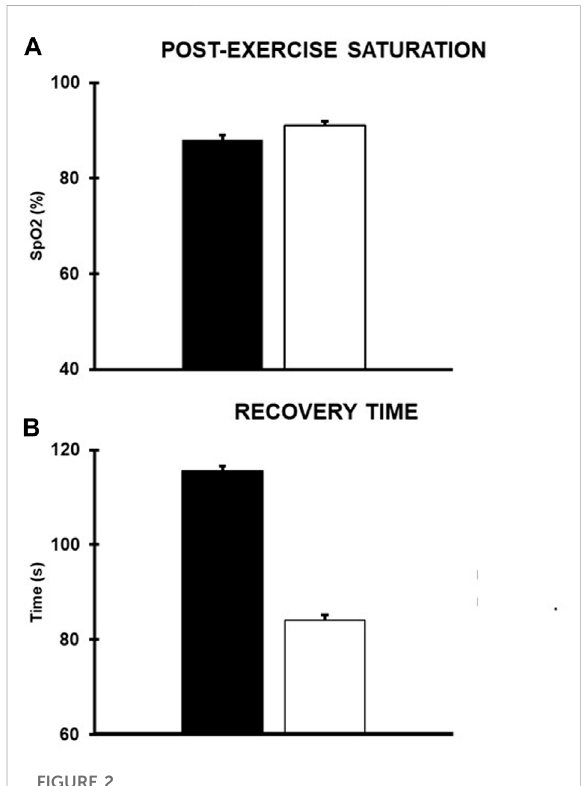
FIGURE 2 Mean values (SD) of the (A) post-exercise saturation and (B) the mean recovery time. Black and white columns refer to the mean values recorded in the fi rst and last 2 months of the second phase of intervention,